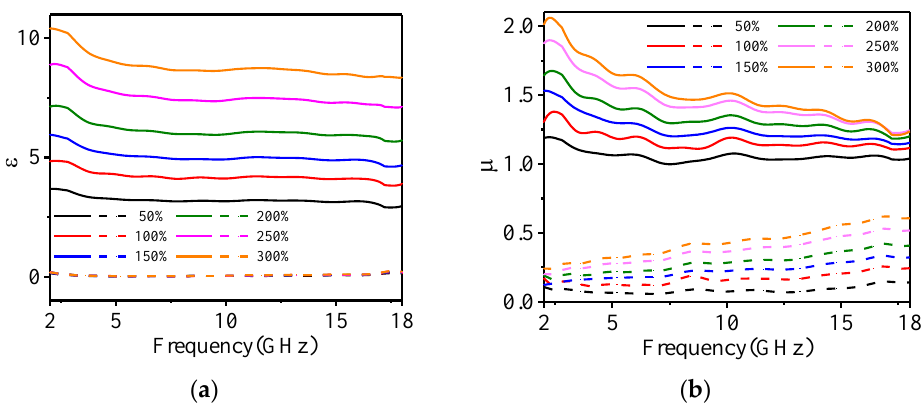
Figure 8. The measured EM parameters of the magnetic substrates; ( a ) is permittivity, and ( b ) is permeability.